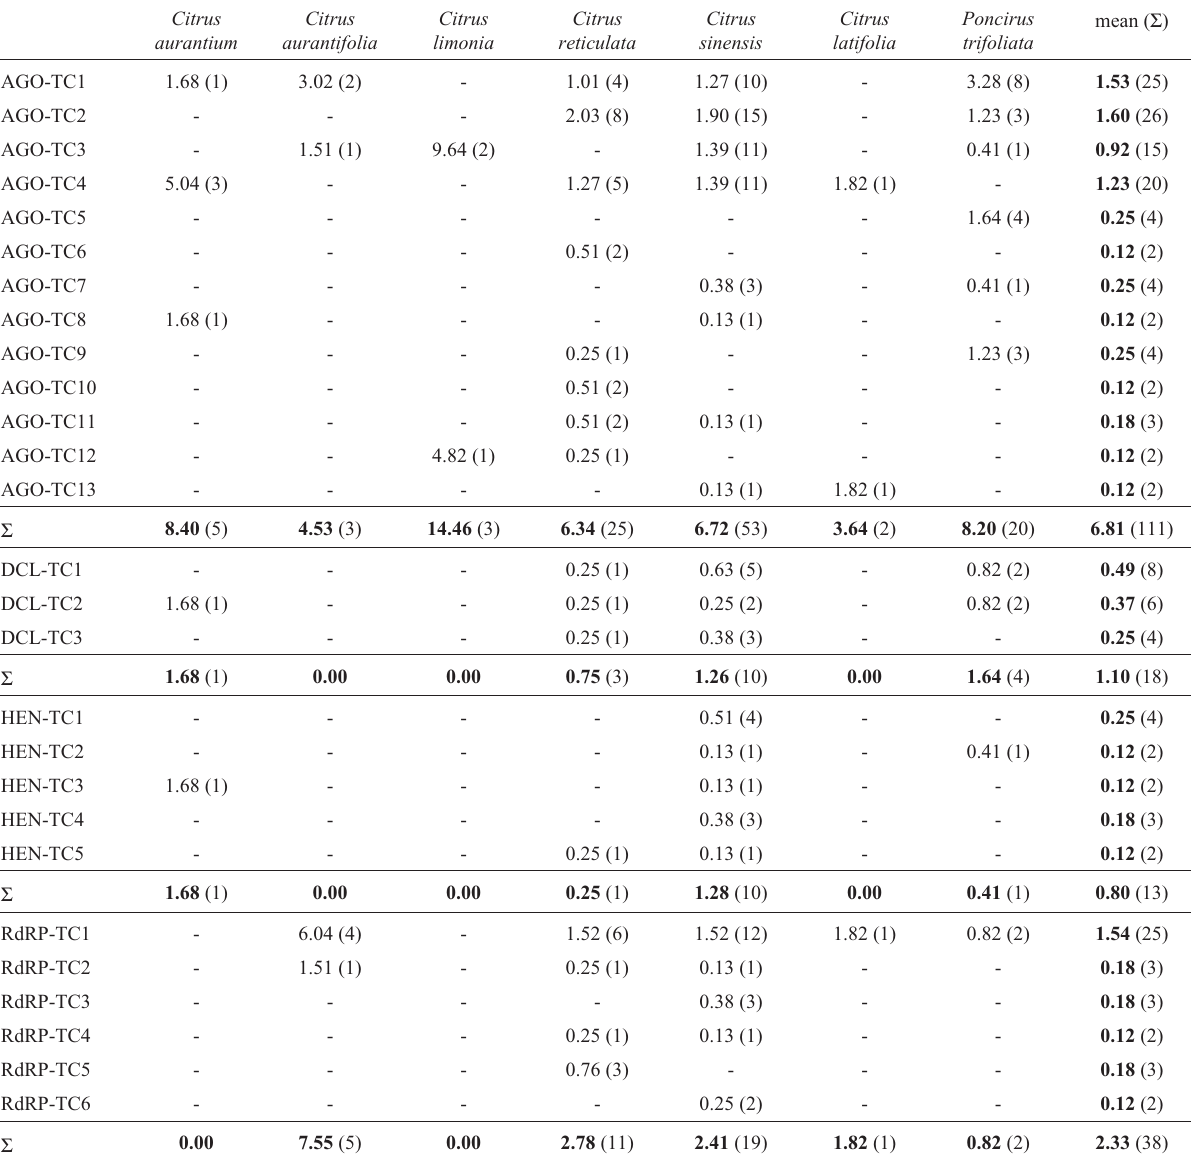
Table 2 - Abundance of reads grouped by species into tentative consensus (TC) of genes involved in RNA silencing pathways in the CitEST database a . Frequency is given per 10,000 transcripts and absolute numbers of valid reads are shown in